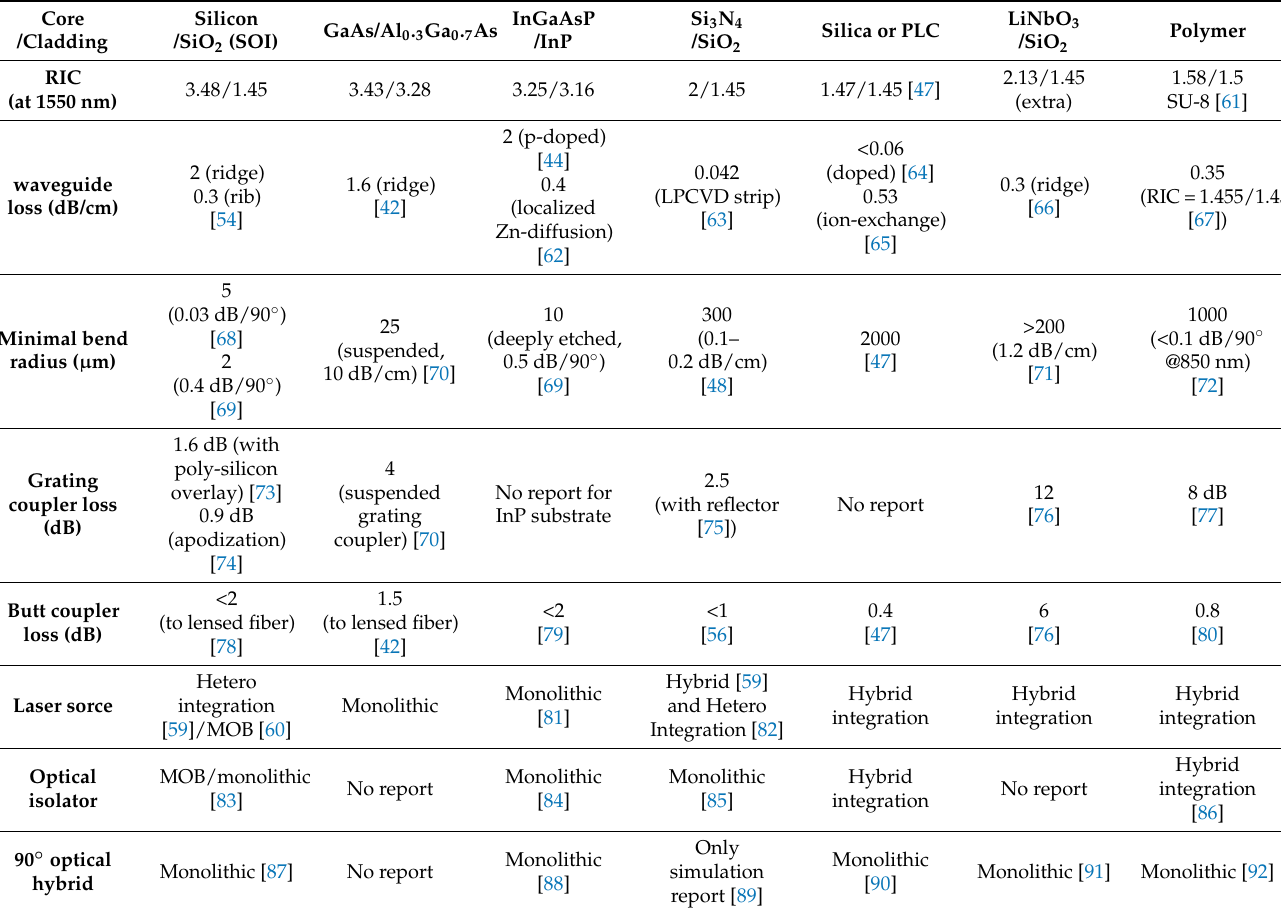
Table 1. A table showing the most typical properties and basic components of different PIC platforms. The table is not meant to be comprehensive but provides typical examples reported in the